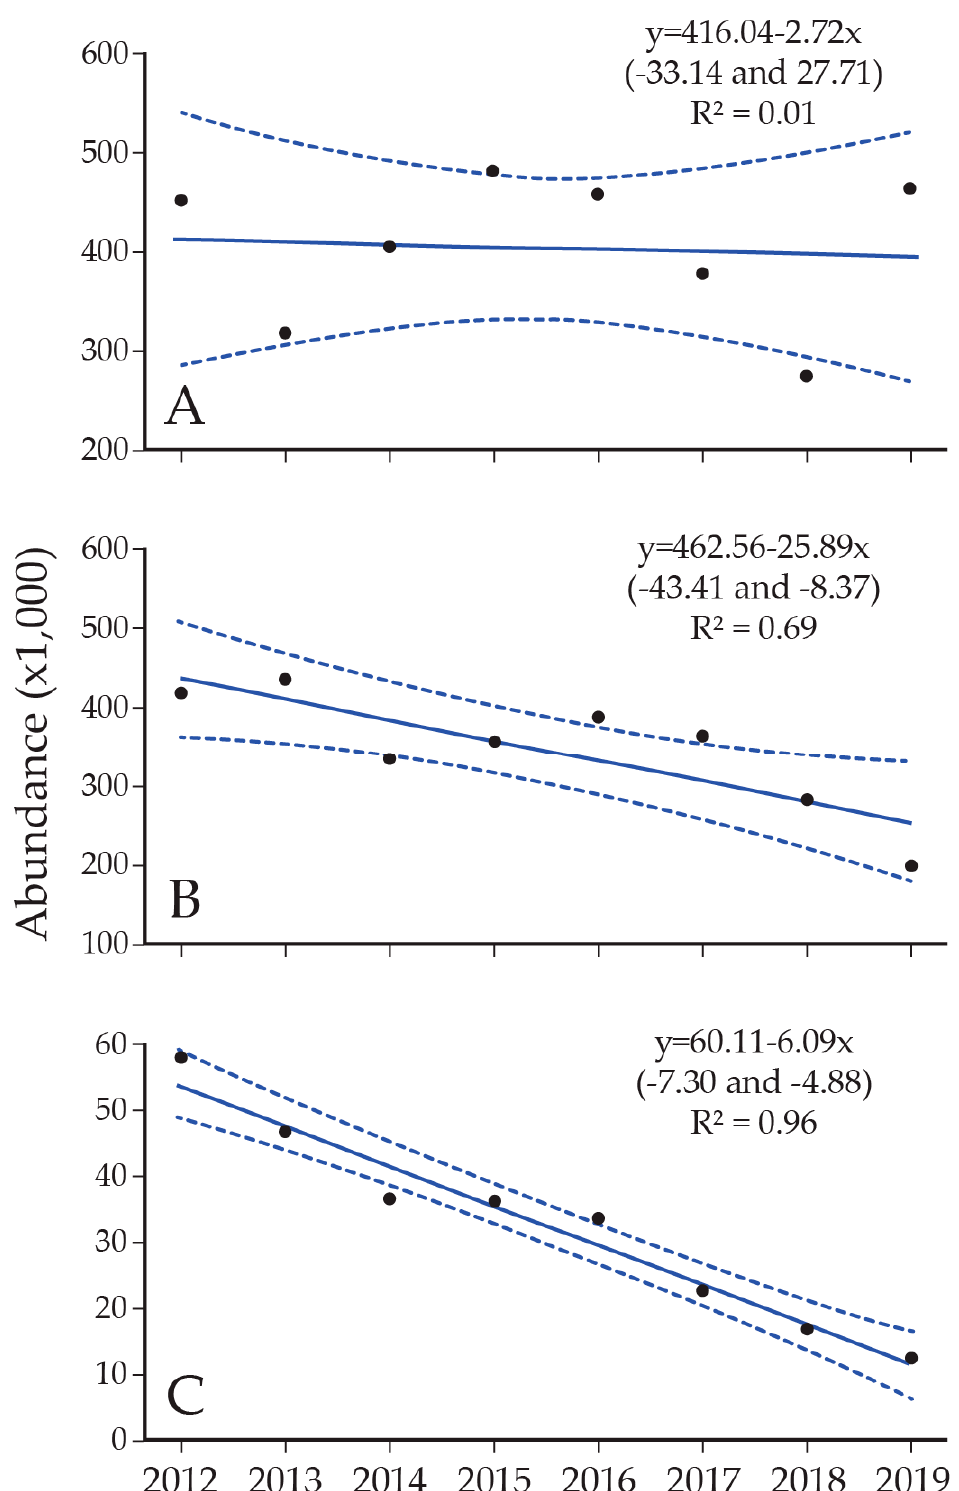
Figure 10. Abundances of ( A ) age-2, ( B ) age-3 to age-5, and ( C ) age-6+ lake trout at the start of the year from 2012 through 2019 estimated using a statistical catch-at-age (SCAA) model [81]. Blue lines represent simple linear regression models with 95% confidence intervals (dashed lines). Numbers within parentheses are the upper and lower 95% confidence limits of the slope parameter estimate. There was no temporal change in age-2 abundance because the interval includes zero. Age-3 to age-5 abundance and age-6+ abundance declined significantly.